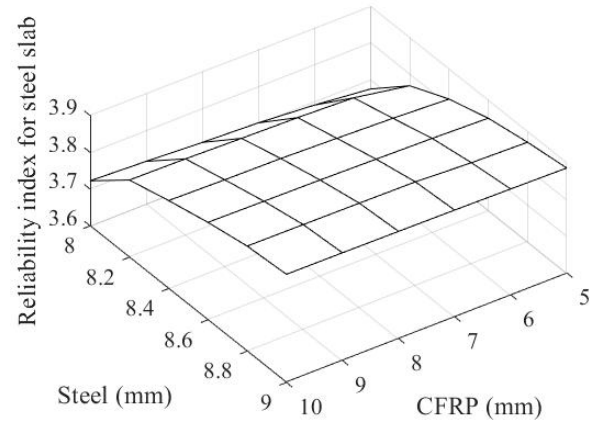
Figure 11. Reliability index of steel slab.